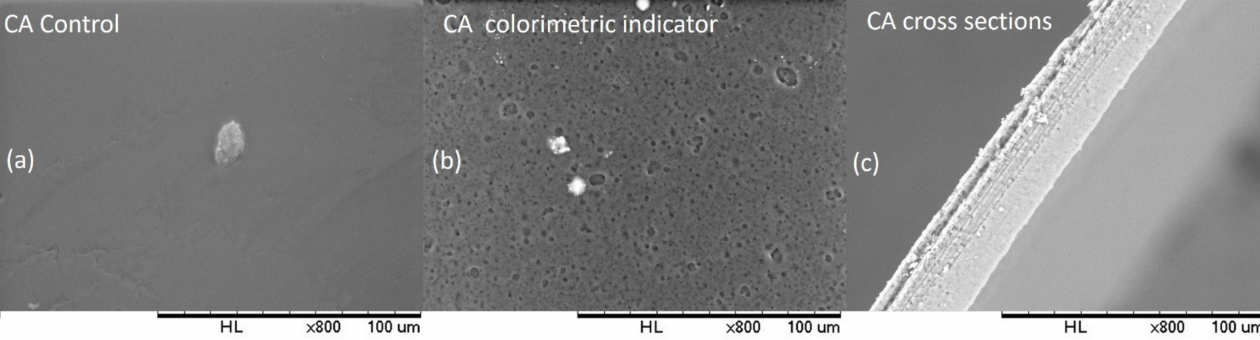
Figure 4. SEM of the AC sensors. ( a ) Film control, ( b ) CA indicator colorimetric, and ( c ) cross sections. The left micrograph shows the surface of the sensors and the right micrograph illustrates the film cross section. All magnifications are 800 × .